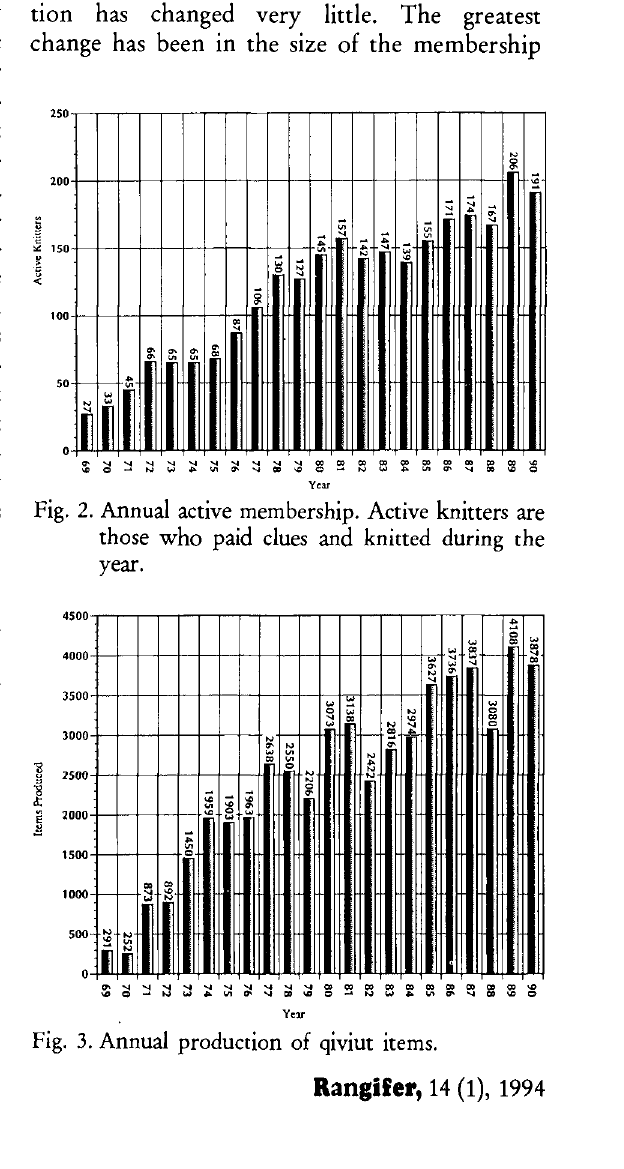
Fig. 2. Annual active membership. Active knitters are those who paid clues and knitted during the year.